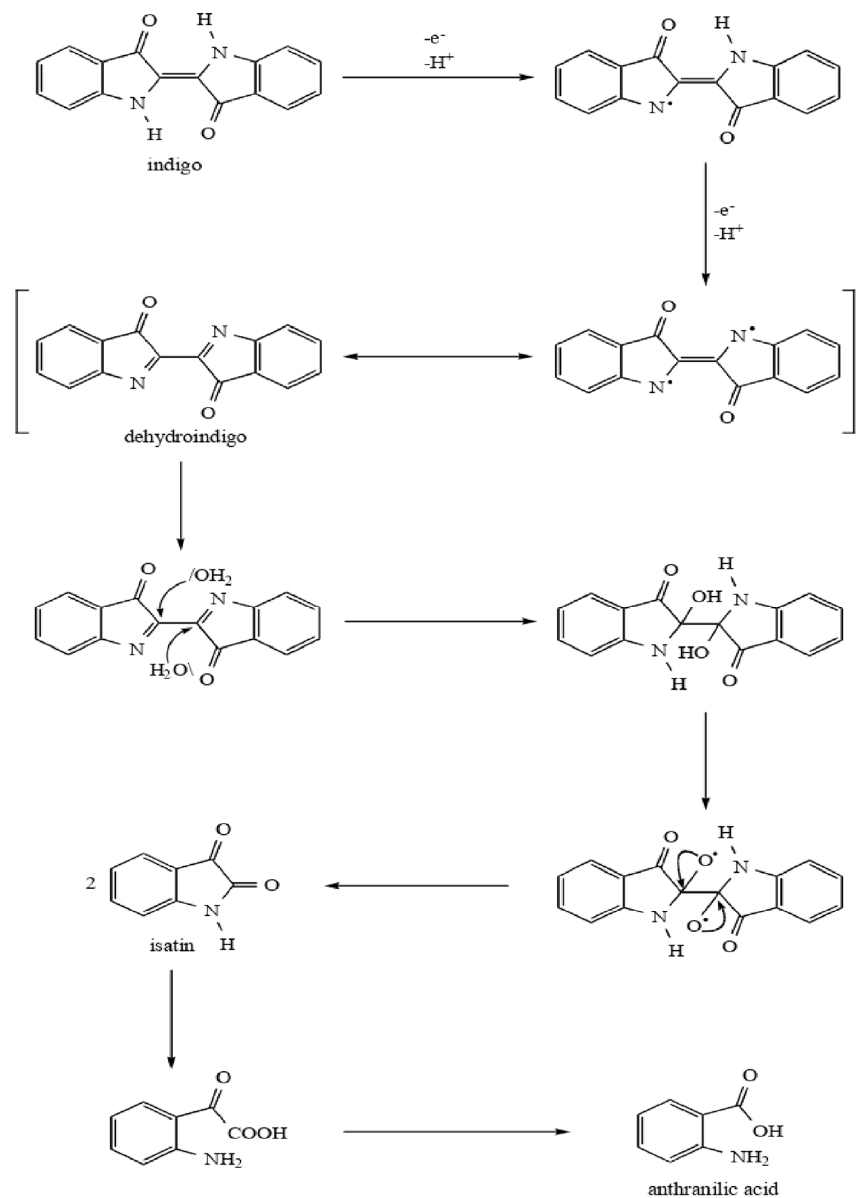
Figure 7. Mechanism of degradation of Indigo dye by using laccase enzyme adopted from [134].